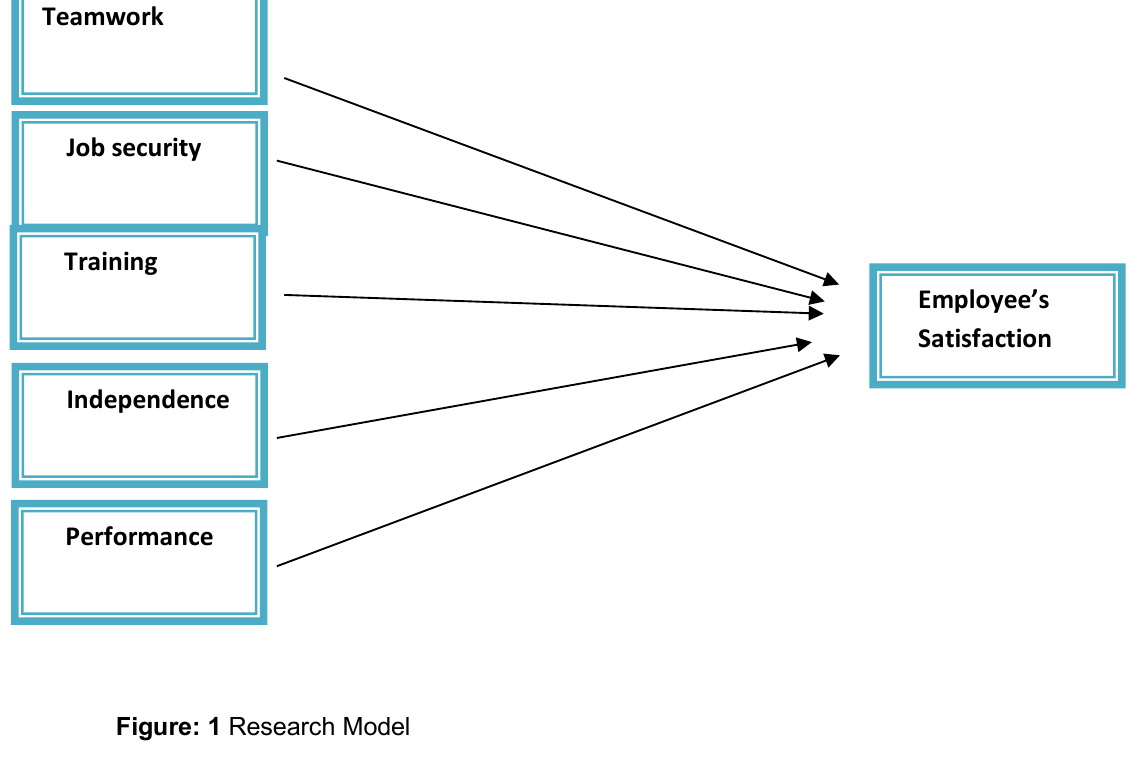
Figure: 1 Research Model